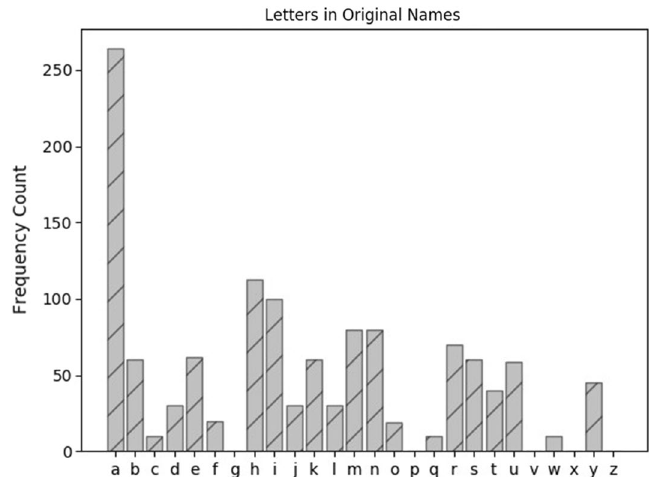
Fig. 10 Frequency analysis of original ’Name’ attribute